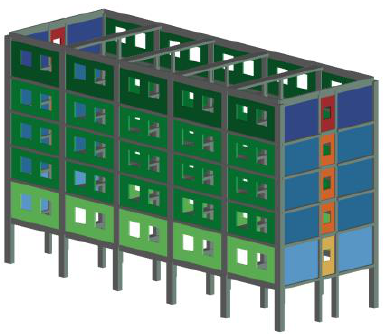
Figure 9. Case study representation with masonry infill panels IDs location.